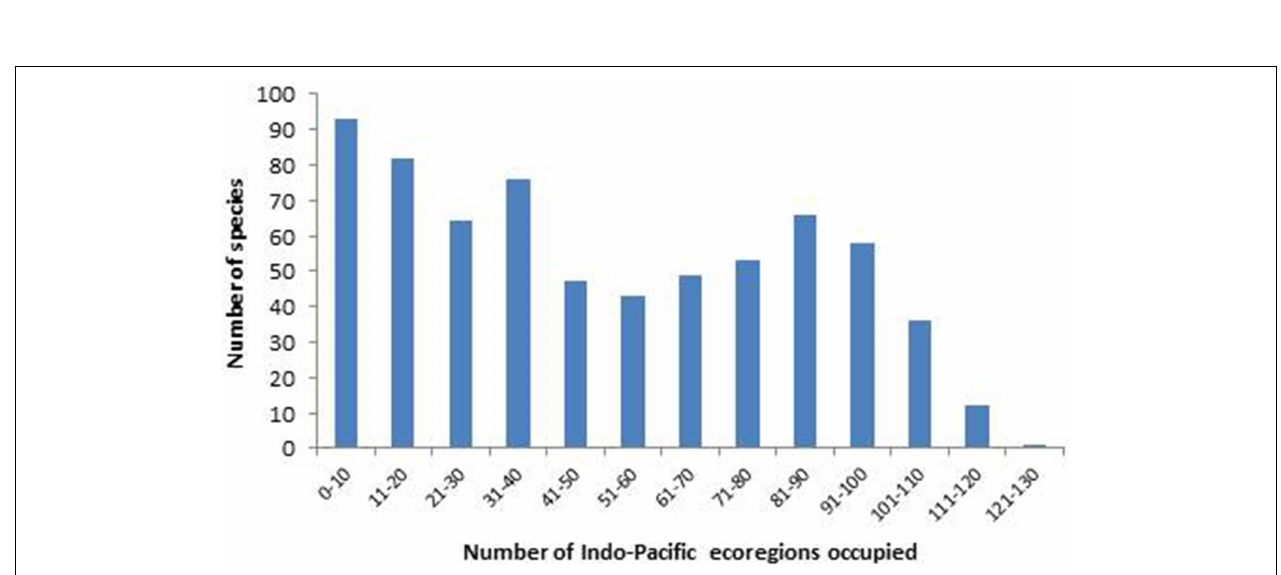
FIGURE 15 | Geographic ranges of confirmed and strongly predicted Indo-Pacific species. Red, latitudinal ranges; blue, longitudinal ranges.